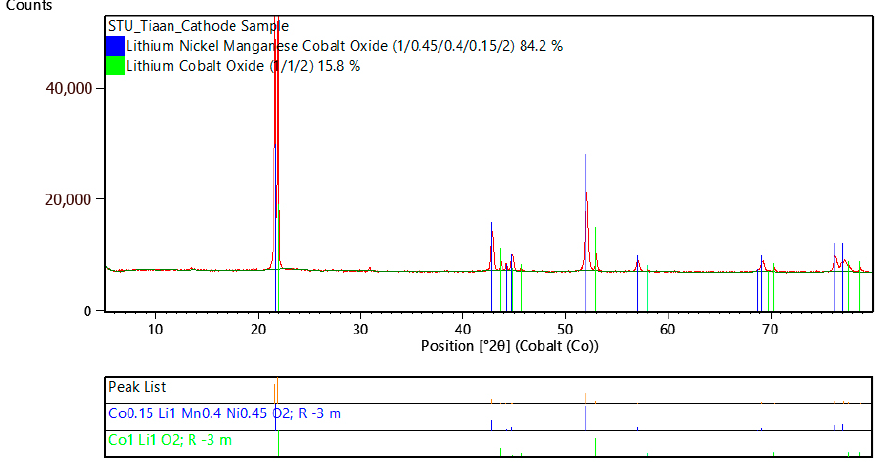
Figure 3. XRD analysis of the black mass powder.